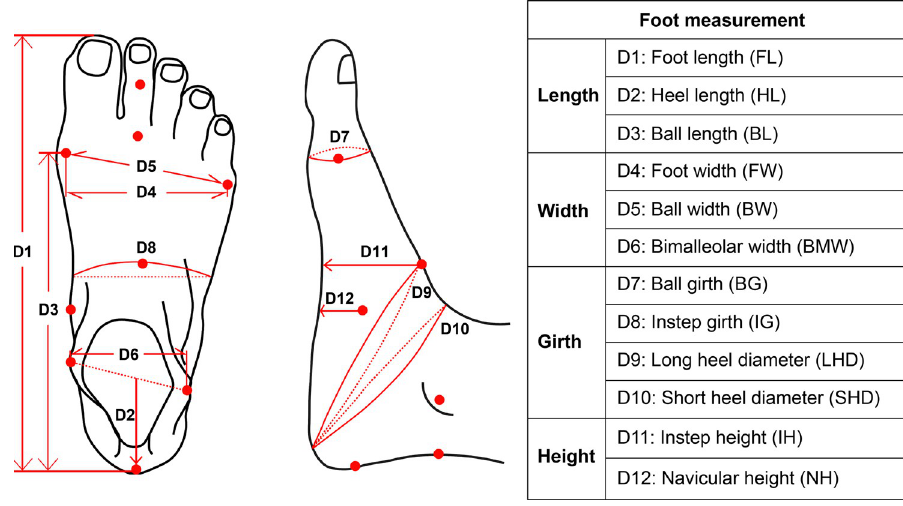
Fig 4. Twelve anthropometric measurements of foot taken from 3D images [59].